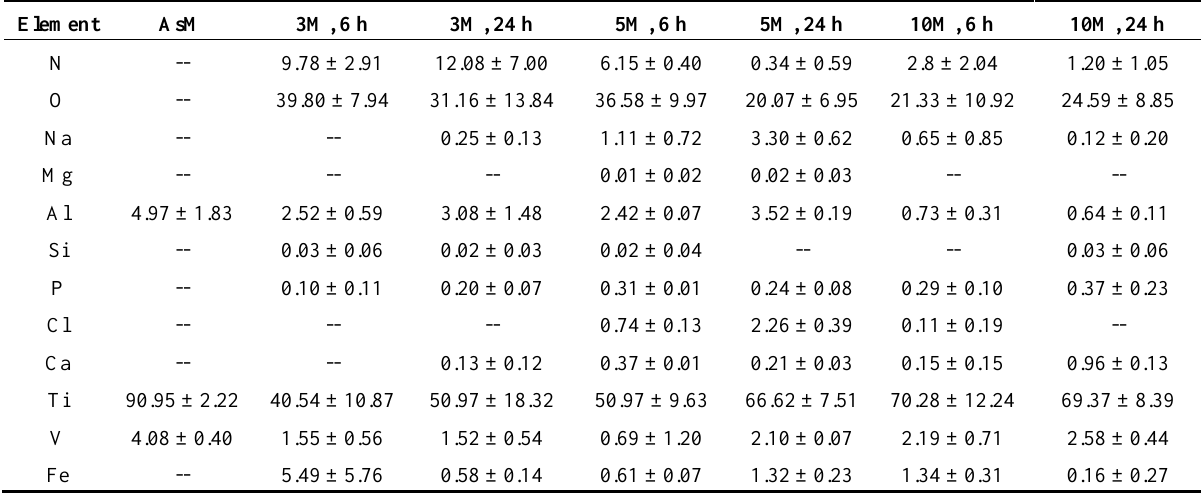
Table 3. EDS elemental analysis (wt. %) after 3 week SBF immersion for AsM and AlAcH treated samples with various alkali concentrations and immersion